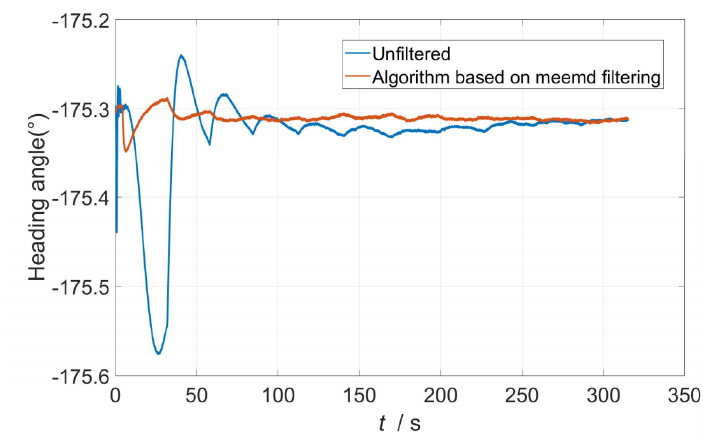
Figure 12. Comparison of the heading angle of the initial alignment